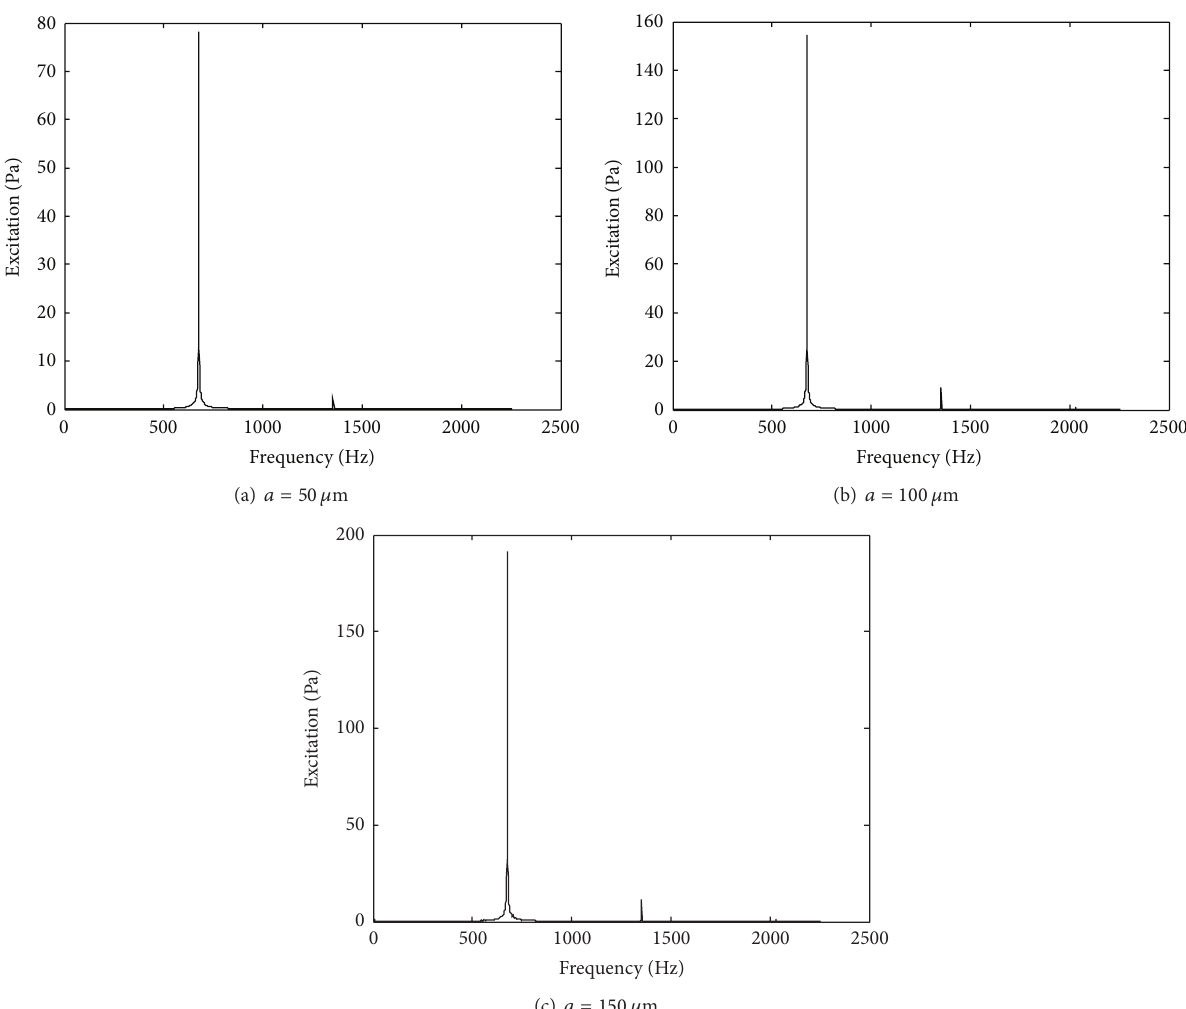
Figure 20: Calculation results of airflow exciting force on the rotor rim surface of Rampressor inlet in different rotor whirling amplitudes.